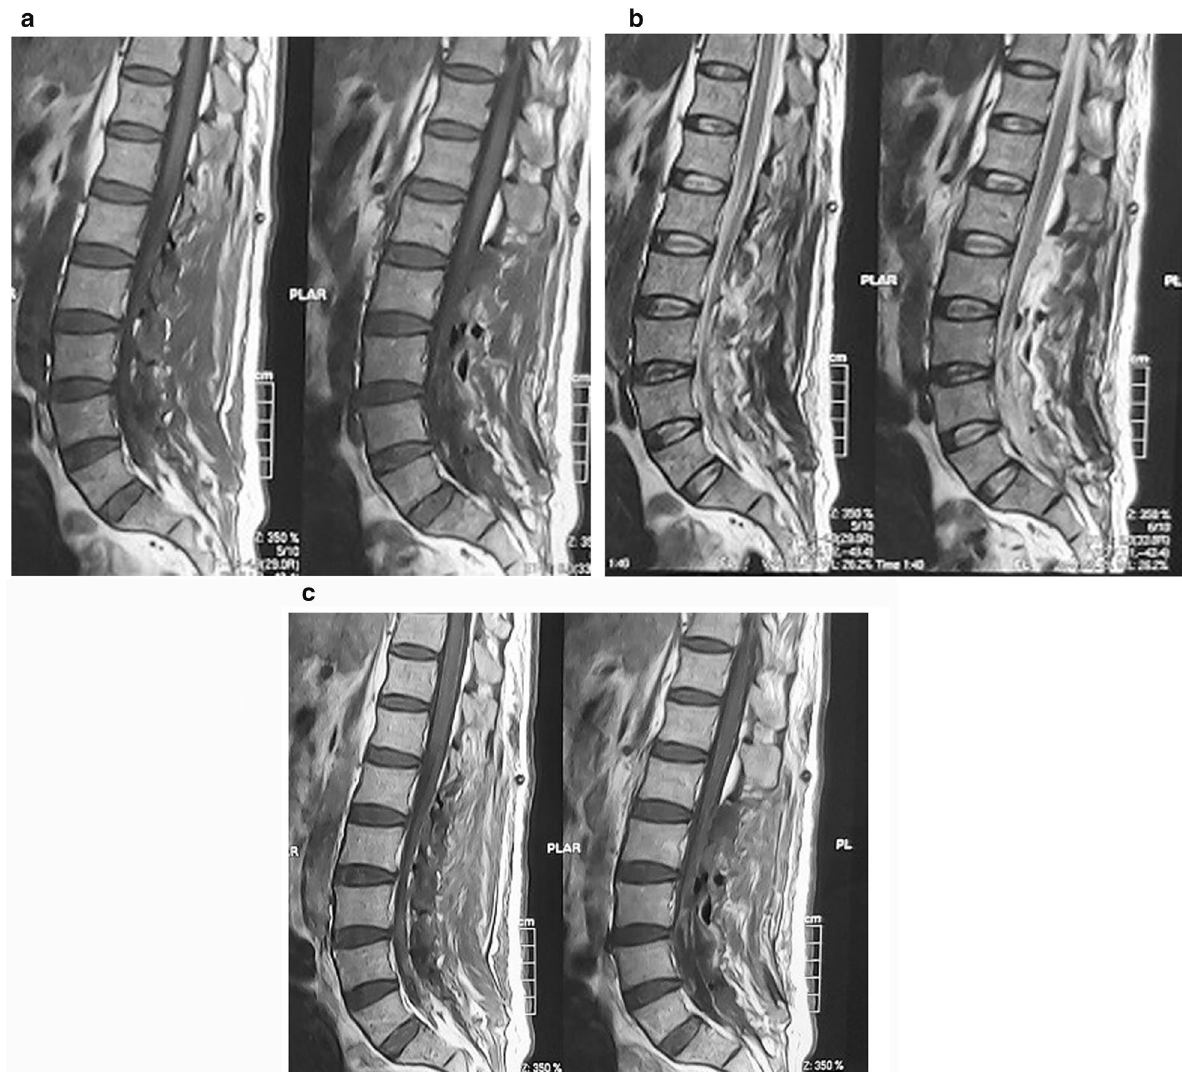
Fig. 4 a : Postoperative T1. The 2-month postoperative imaging demonstrated a complete resection of the tumor. b : Postoperative T2. The 2-month postoperative imaging demonstrated a complete resection of the tumor. c : Postoperative T1 contrast. The 2-month postoperative